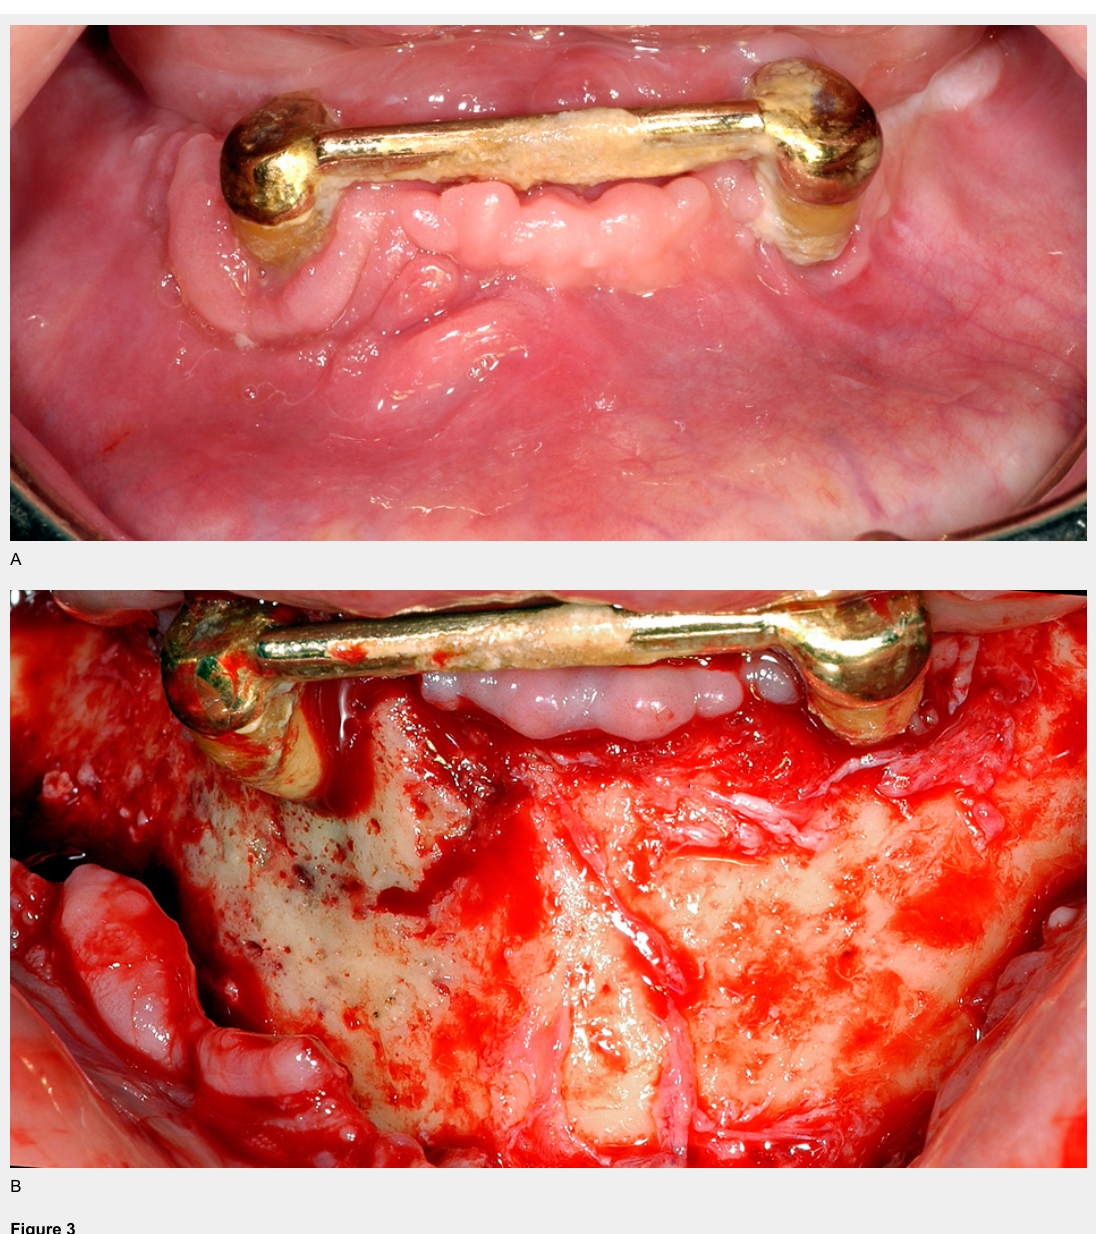
Figure 3 A Female patient with BRONJ of the right anterior mandible associated with periapical infection of the canine. The clinical picture shows no exposed bone, but signs of infection of the surrounding soft tissue and periodontal pus discharge. B The same patient as figure 3A. Intraoperative view shows clearly the necrotic bone area in contrast to the vital bone in the left mandible. The necrotic area is surrounded from granulation tissue. Bone appears